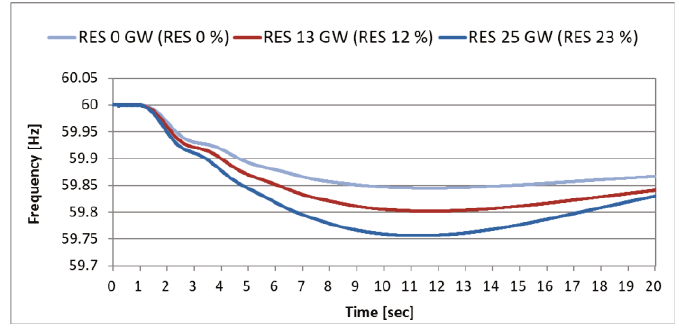
Figure 8. Frequency response simulation of the Korean power system with increasing RES penetration.